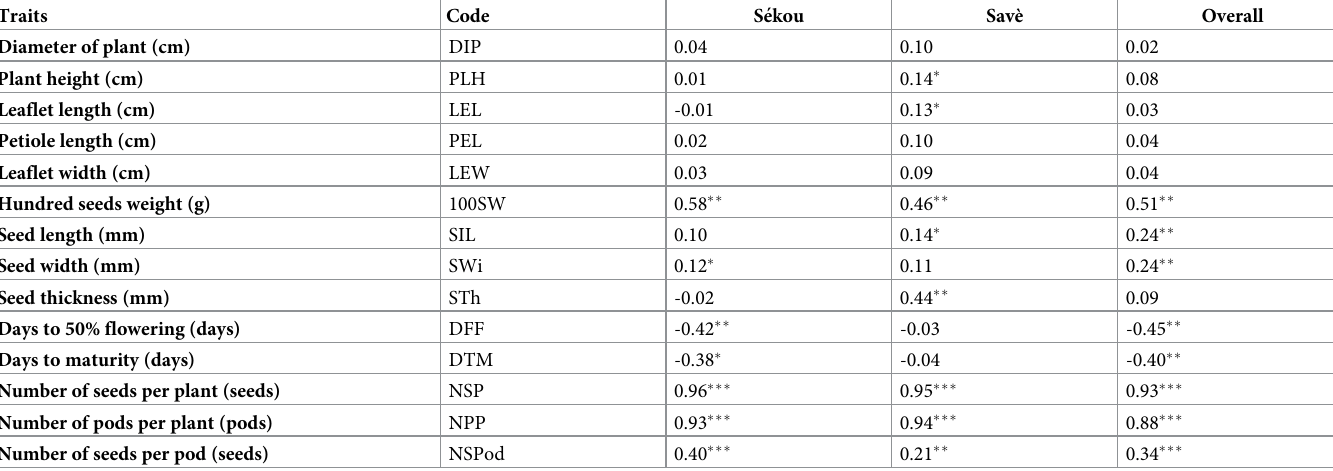
Table 5. Pearson correlations between grain yield per plant and other Kersting’s groundnut morphological traits. Traits Code Sav è